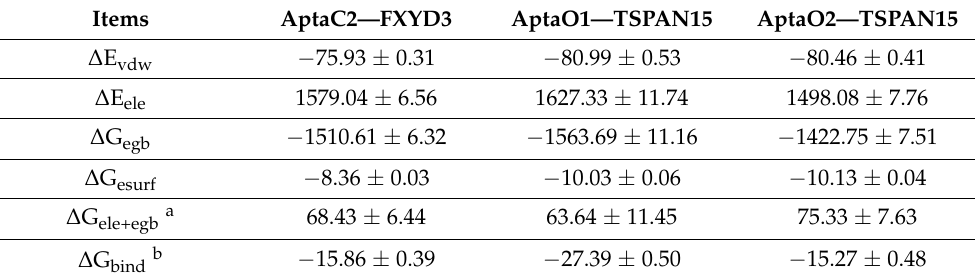
Table 3. Binding free energies for complexes calculated by the MM/GBSA method.